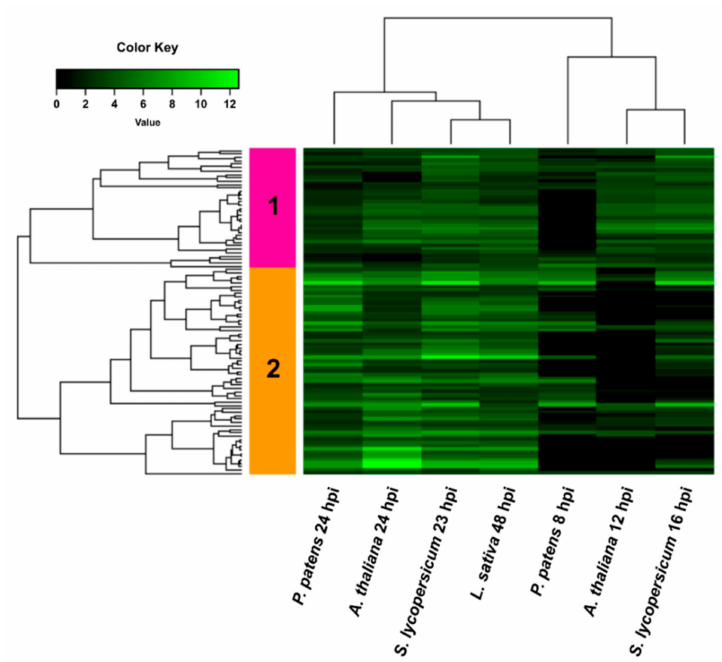
Figure 5. Heatmap of hierarchical clustering of common upregulated B. cinerea DEGs during infection of P. patens and different angiosperms. DEGs correspond to the 96 common upregulated genes of B. cinerea grown in all plant species. Selected DEGs had log2 FC ≥ 2, FDR ≤ 0.05, and were expressed differentially in at least one time point for each plant species. For samples where no significant difference with control was observed (FDR > 0.05) or no data was available, the log2 FC was assigned as cero. See Table S11 for complete